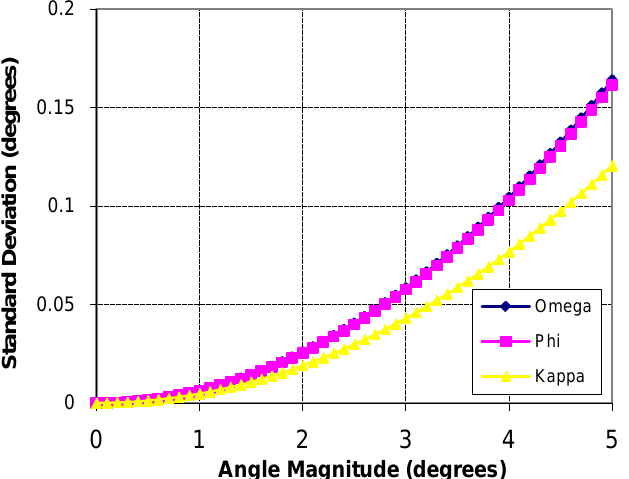
Figure 6. Simulation Results of the Dual-Antenna Case showing precision of calculated orientation angles vs. their magnitude over the first 5 degrees; the 1 mrad precision is possible with orientation angles smaller than 3